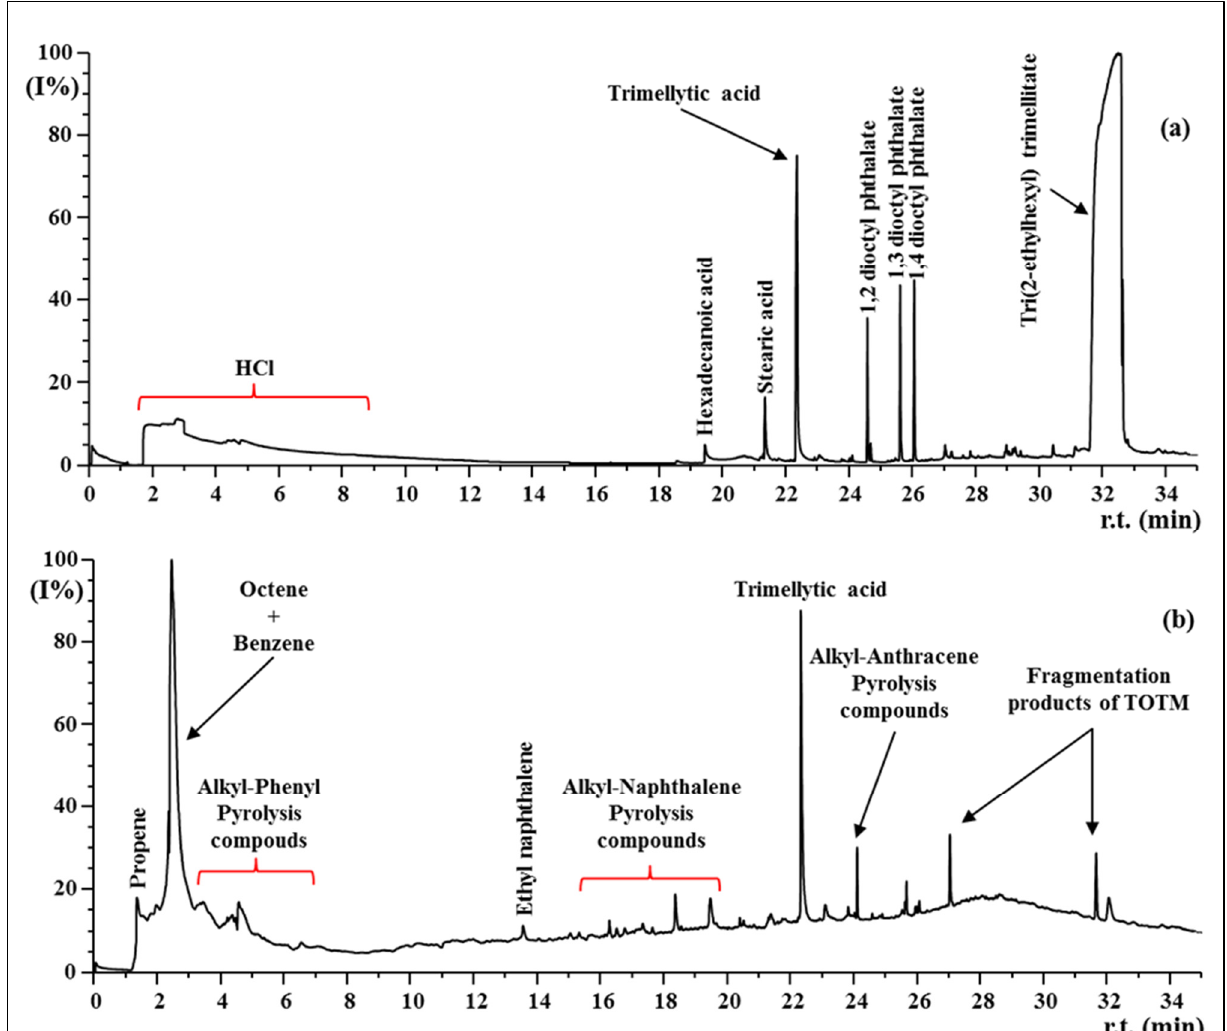
Figure 10. Py-GC/MS pyrograms of the thermal products of the plasticized PVC recorded at ( a ) 300 °C and ( b ) 450 °C. and ( b ) 450 ◦